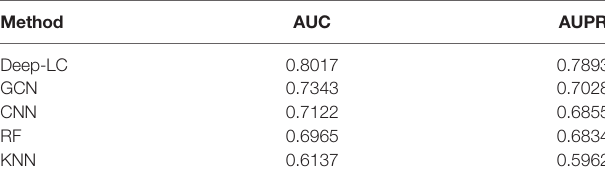
TABLE 3 | The AUC and AUPR scores of Deep-LC and other four methods.